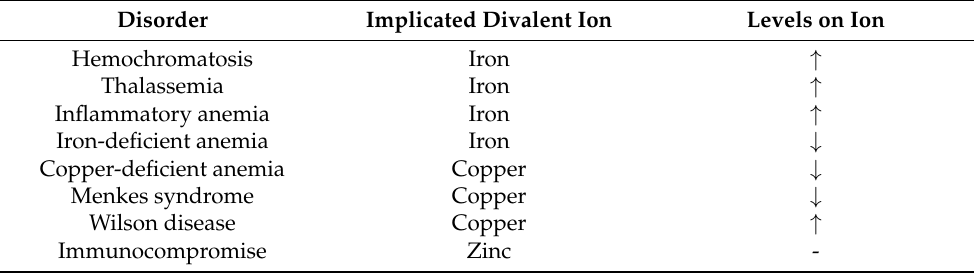
Table 1. Common disorders secondary to Fe, Cu, Zn deficiency or